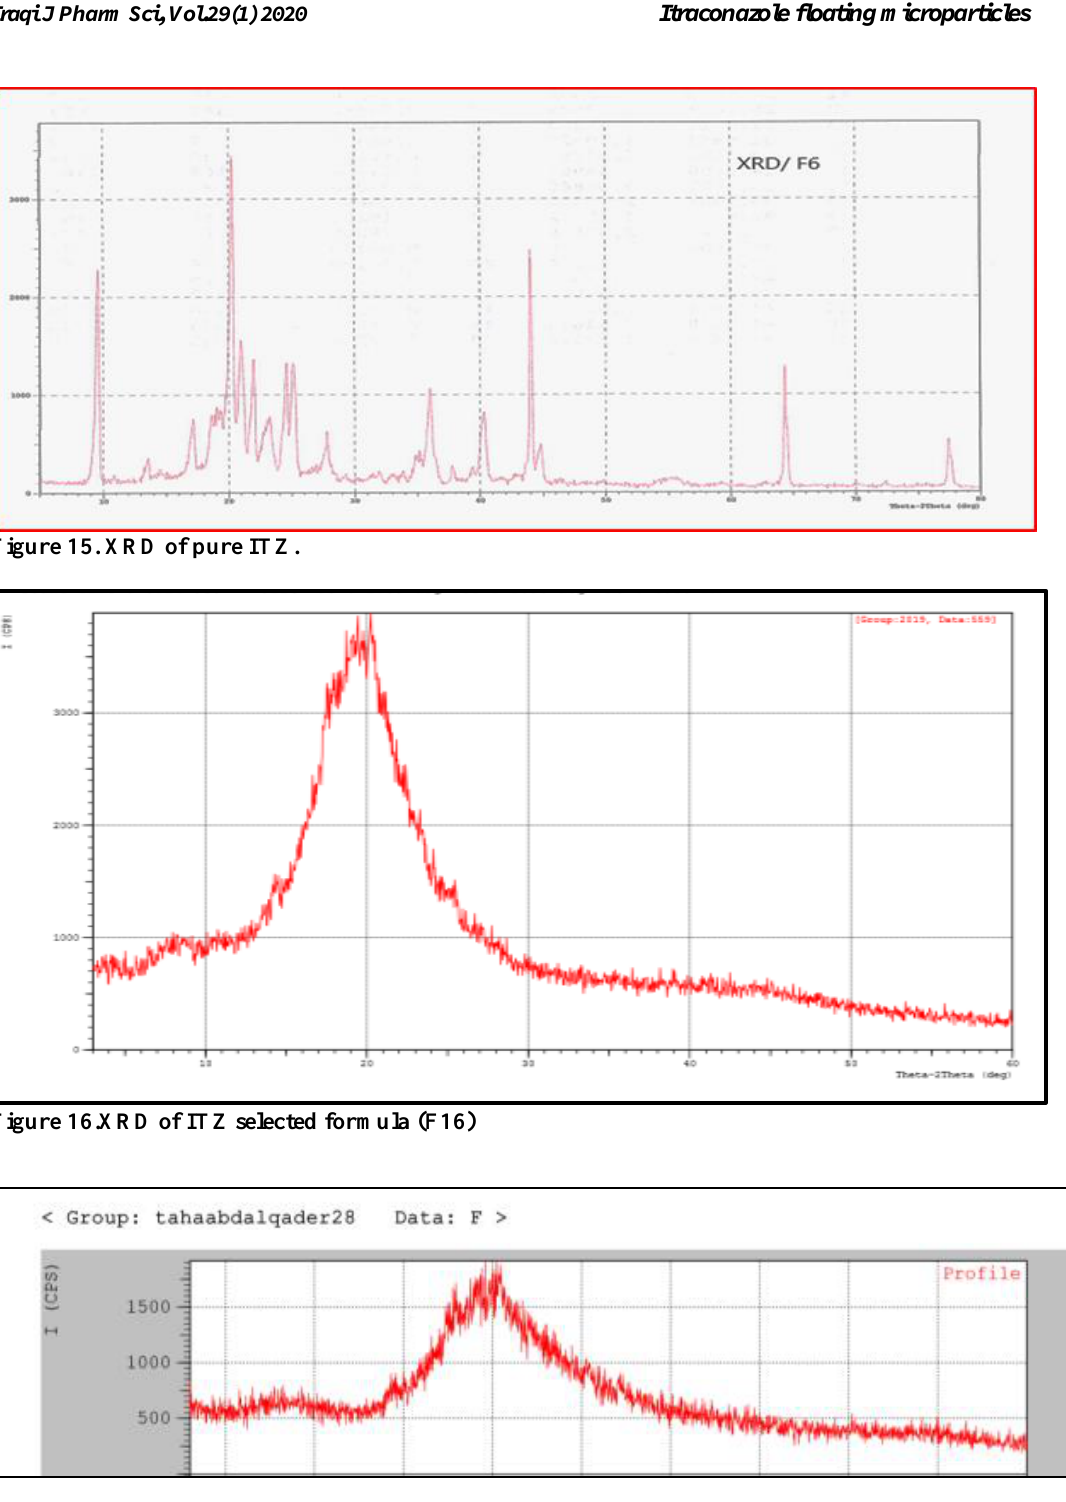
Figure 17. XRD of ITZ best pH-dependent formula ( F7)